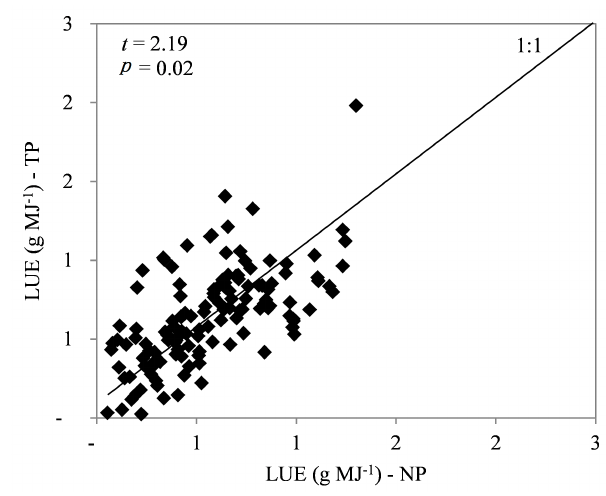
Figure 6. Correlation between light use efficiency (LUE) in twin plots (TP) and normal plots (NP).